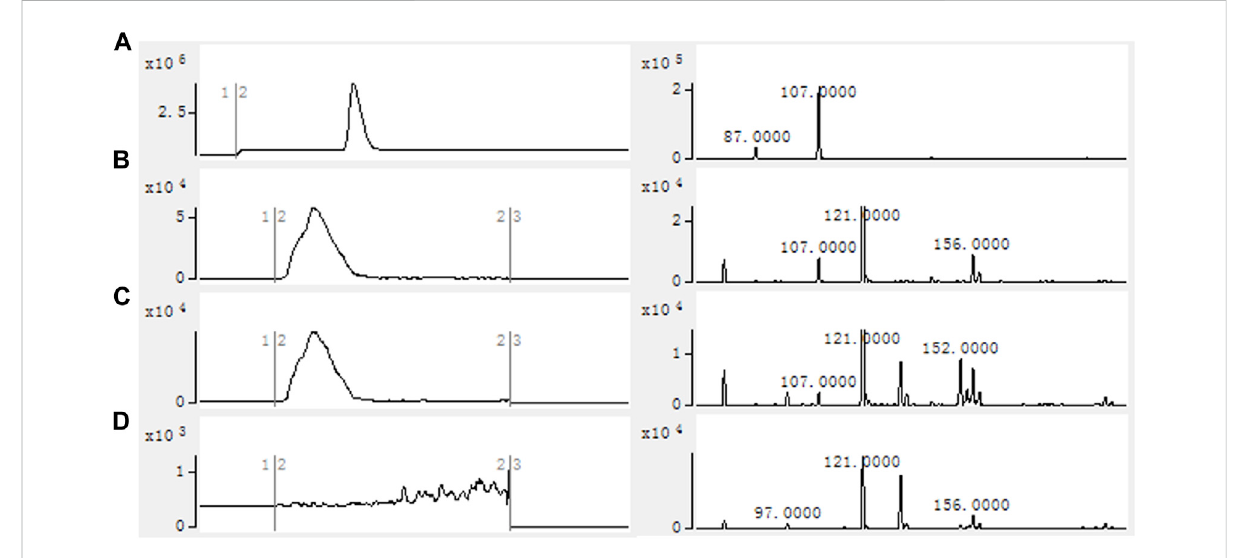
FIGURE 3 HPLC-MS results of in vitro catalytic reaction of crude enzyme. (A) 2-F-3-HP standard; (B) Strain 1 containing 2-F-3-HP standard; (C) Strain 2; (D) Strain 1. Reactions were performed in 100 mM Tris-HCl buffer (pH 7.8) containing 1 mg/ml crude enzyme, 20 mM 2-FMA, 2 mM NADPH, 2